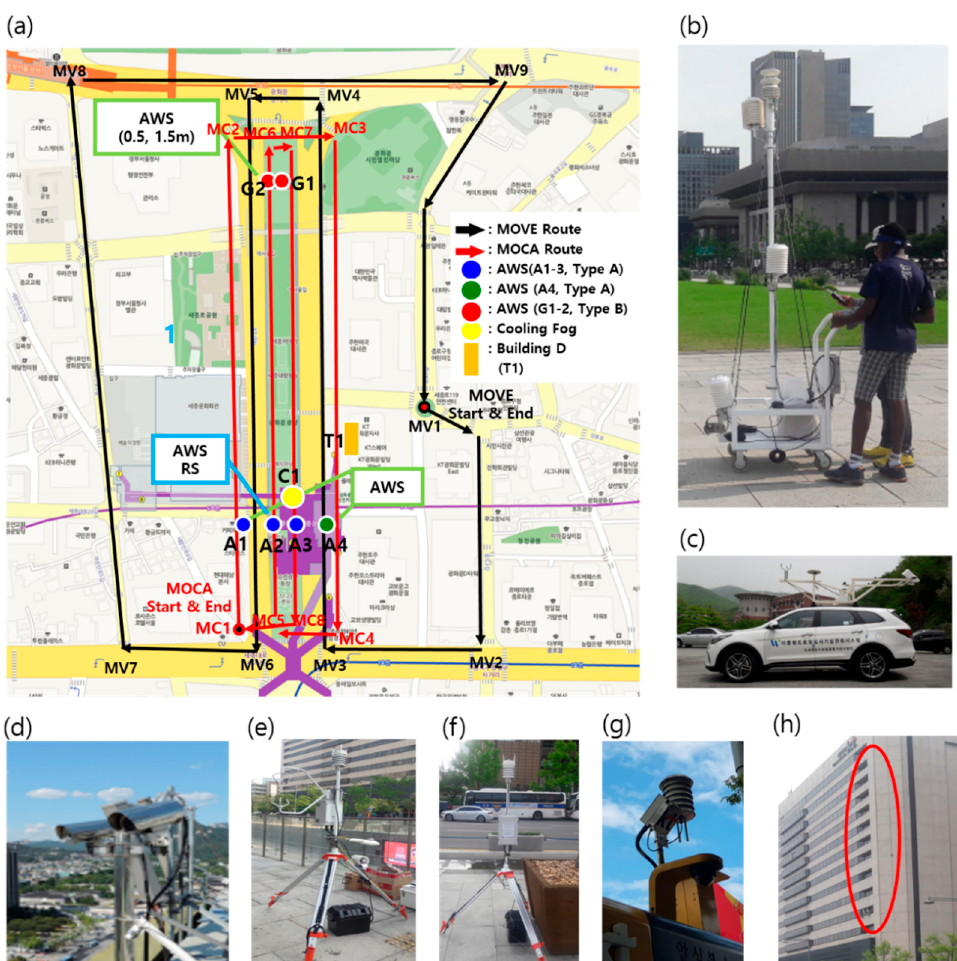
Figure 3. ( a ) Location of fixed instruments and sensors, and MOCA and MOVE during the BBMEX, ( b ) MOCA, ( c ) MOVE, ( d ) thermal infrared imagery, ( e ) radiation and turbulence measurement system, ( f ) integrated meteorological measurement system, ( g ) integrated meteorological sensor installed over public telephone box, and ( h ) integrated meteorological sensors deployed at 7 levels outside building D.